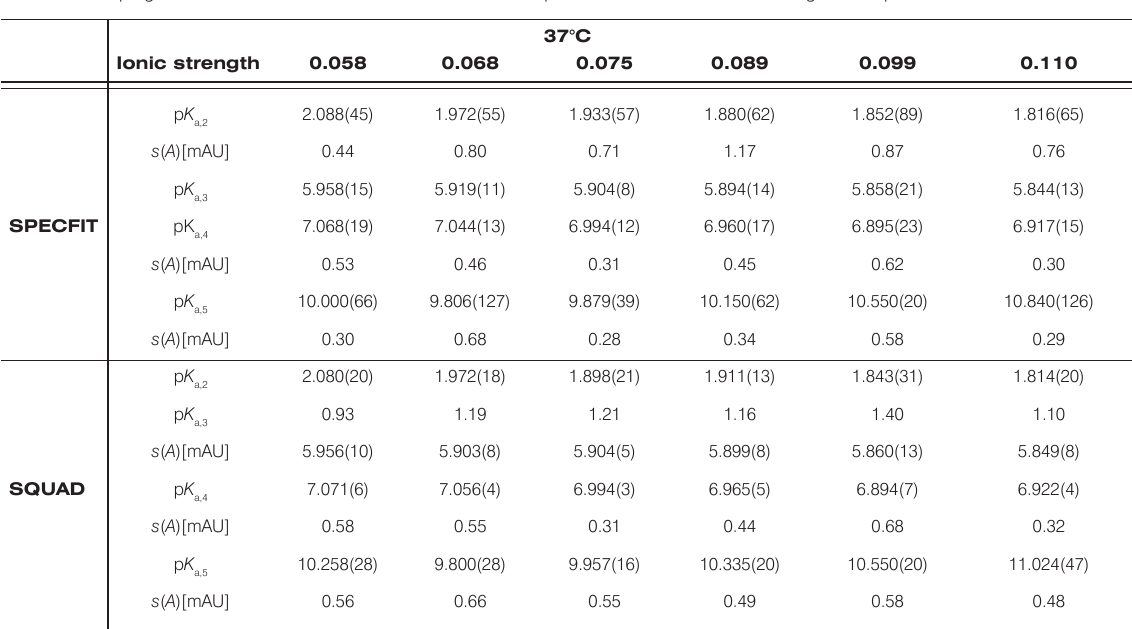
Figure 6. Protonation equilibria of risedronate analyzed with ESAB: (a) Potentiometric titration curve of risedronate with KOH and Bjerrum protonation Z -function; L = 4.9035 ×10 -3 mol dm -3 , H = 0.8961 mol dm -3 , V = 15.3 cm 3 , I = 0.025, t = 25°C; (b) Distribution diagram 0 T 0 , LH and LH of risedronate depending on pH at 25ºC, (ESAB, of relative presentation of all variously protonated species L, HL, HL 2 3 4 HYPERQUAD, ORIGIN).The charges of species are omitted for the sake of Table 3. Mixed dissociation constants p K of risedronate at 37°C and various values of an ionic strength I estimated by nonlinear regression a,i programs SPECFIT and SQUAD. Standard deviations of parameter estimates in last valid digits are in parentheses.